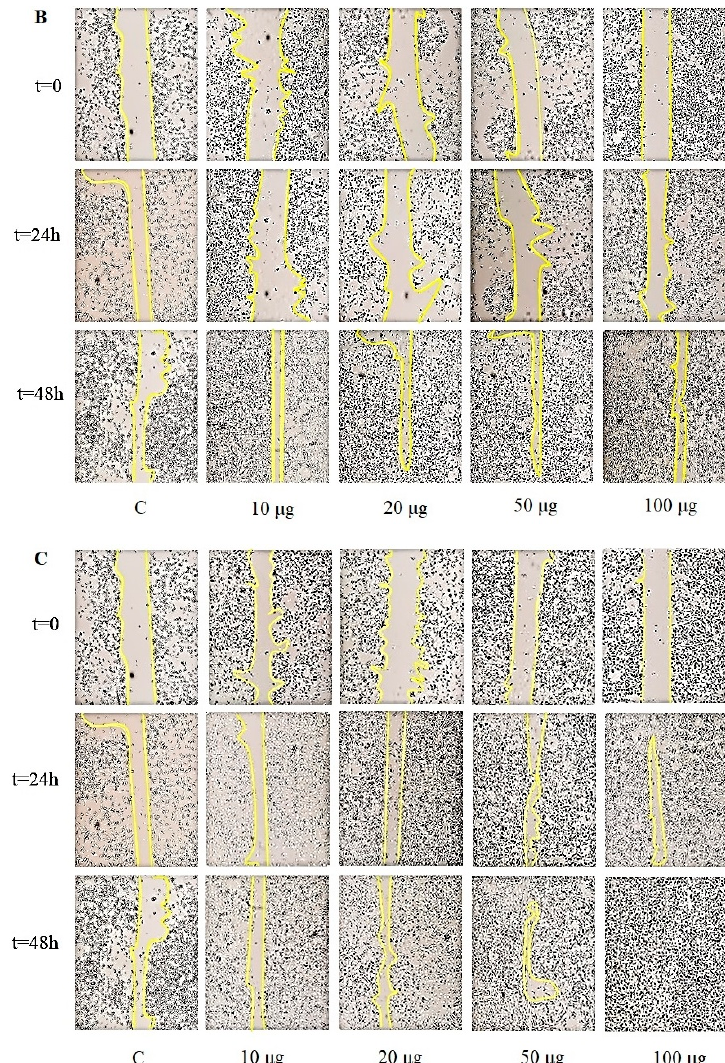
Figure 8. Representative images of time course scratch assay of HaCat cells treated with different concentration of soluble glucans ( A ) SGJ1 (soluble glucans from jujubes of first harvesting); ( B ) SGJ2 (soluble glucans from jujubes of second harvesting); and ( C ) SGJ3 (soluble glucans from jujubes of third harvesting), compared to control (C = untreated). Yellow line indicates the site of the scratch wound.